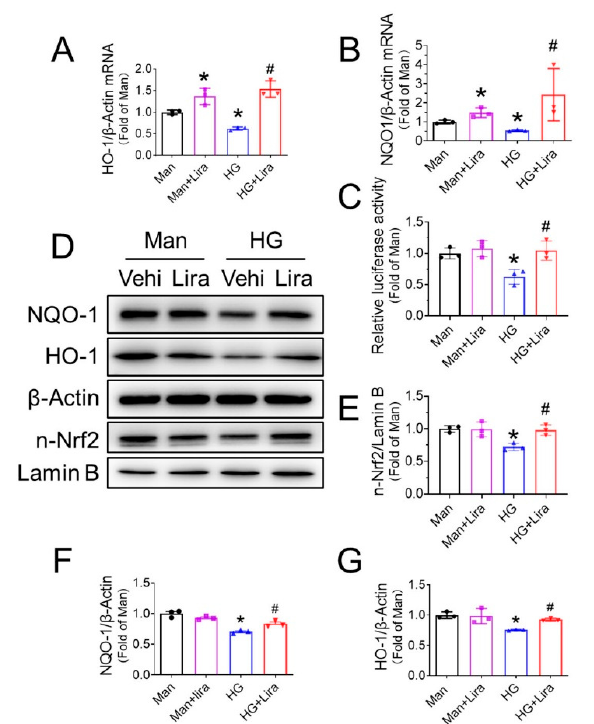
Figure 5. Liraglutide activates Nrf2 in HG-treated EPC. The mRNA expression of HO-1 ( A ) and NQO-1 ( B ) in EPC from different groups was detected by sqRT-PCR. The activity of Nrf2 was evaluated by dual-luciferase assay using ARE luciferase reporter plasmid ( C ). The expression of HO-1, NQO-1 in whole cell lysis and the expression of Nrf2 in nuclear were determined by western blot ( D ), and quantified using Imagequant ( E – G ). β -Actin and Lamin B were used as loading control of whole cell lysate and nuclear lysate, respectively. Three independent experiments were performed for each study. * p < 0.05 vs. Man group; # p < 0.05 vs. HG group.